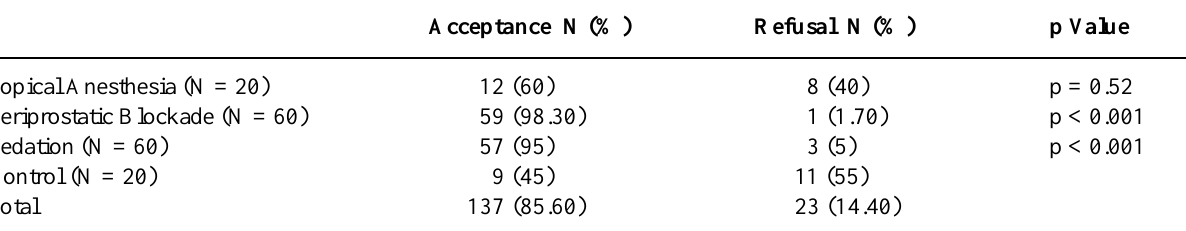
Table 3 – Acceptance of a possible repetition biopsy. Comparison between control group and analgesia group.